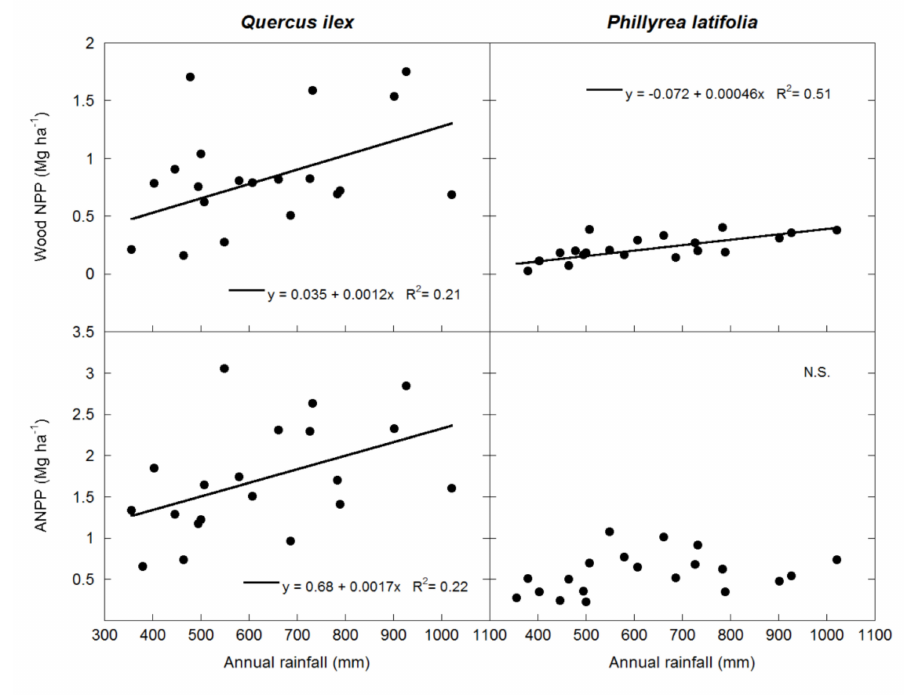
Figure 2. Linear relationships between wood NPP and ANPP values, and annual rainfall in the two dominant species of the studied forest.